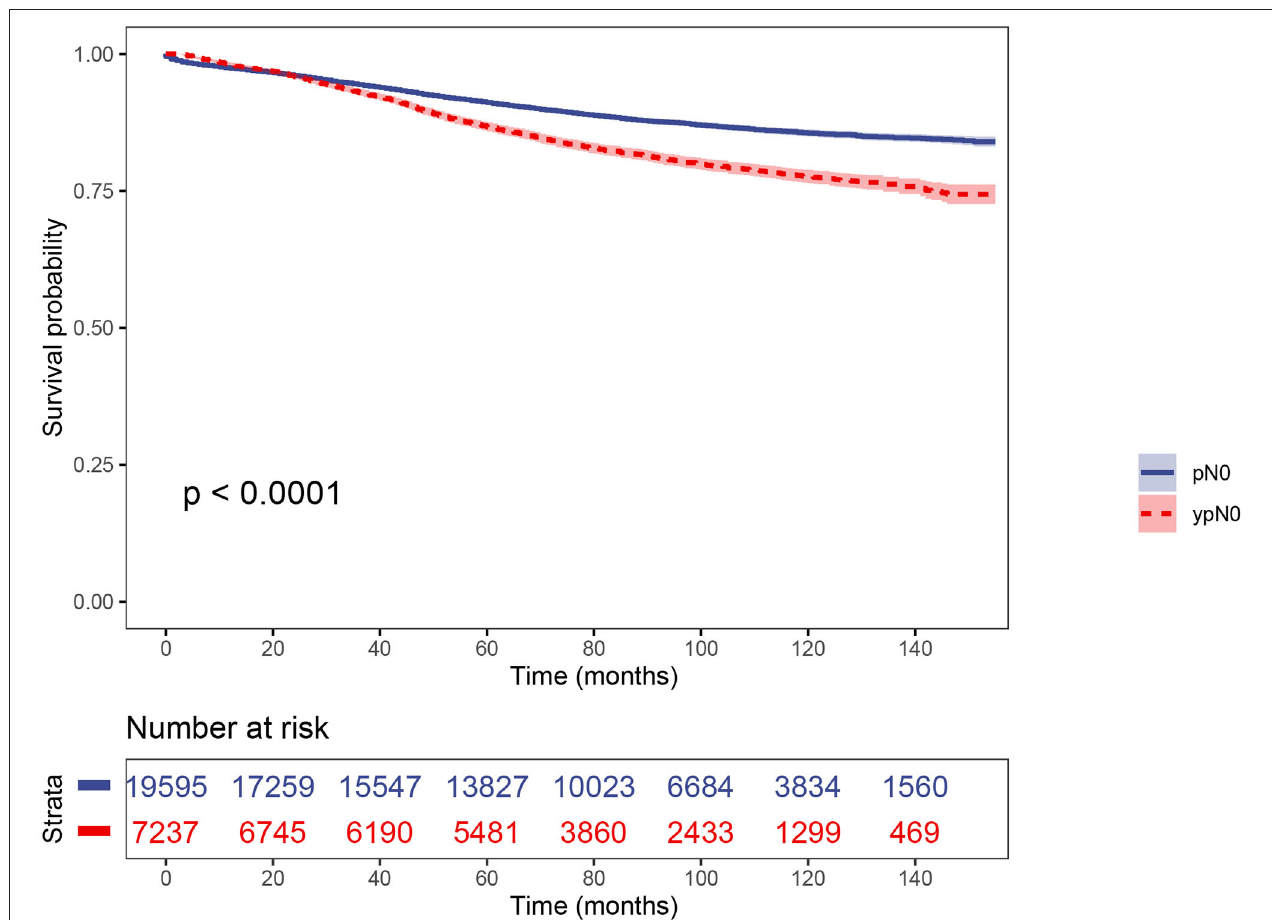
FIGURE 3 | The CSS curves of ypN0 and pN0 groups using Kaplan-meier estimates before